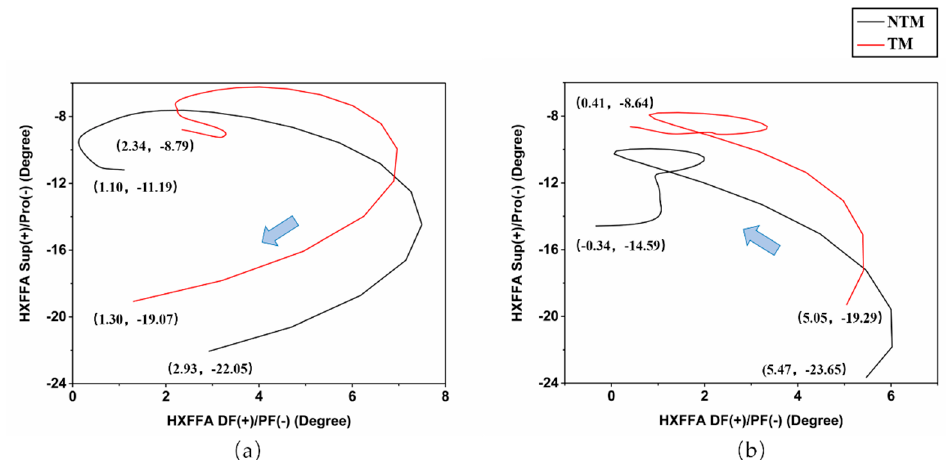
Figure 4. The sagittal (X-axis) and frontal (Y-axis) HXFFA angles during take-off ( a ) and landing ( b ) phases in Non-Toe-Manipulation ( NTM ) and Toe-Manipulation ( TM ) sessions. Abbreviations: DF: dorsiflexion, PF: plantarflexion, Sup: supination, Pro: pronation.